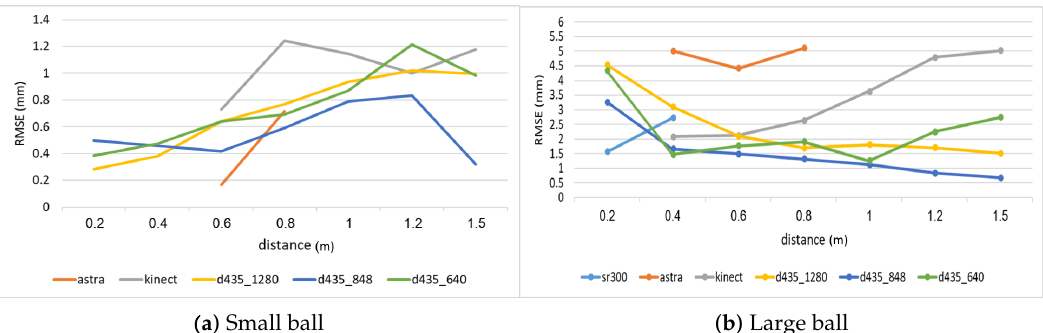
Figure 9. RMSE for diameter estimation of the two balls from varying distances.